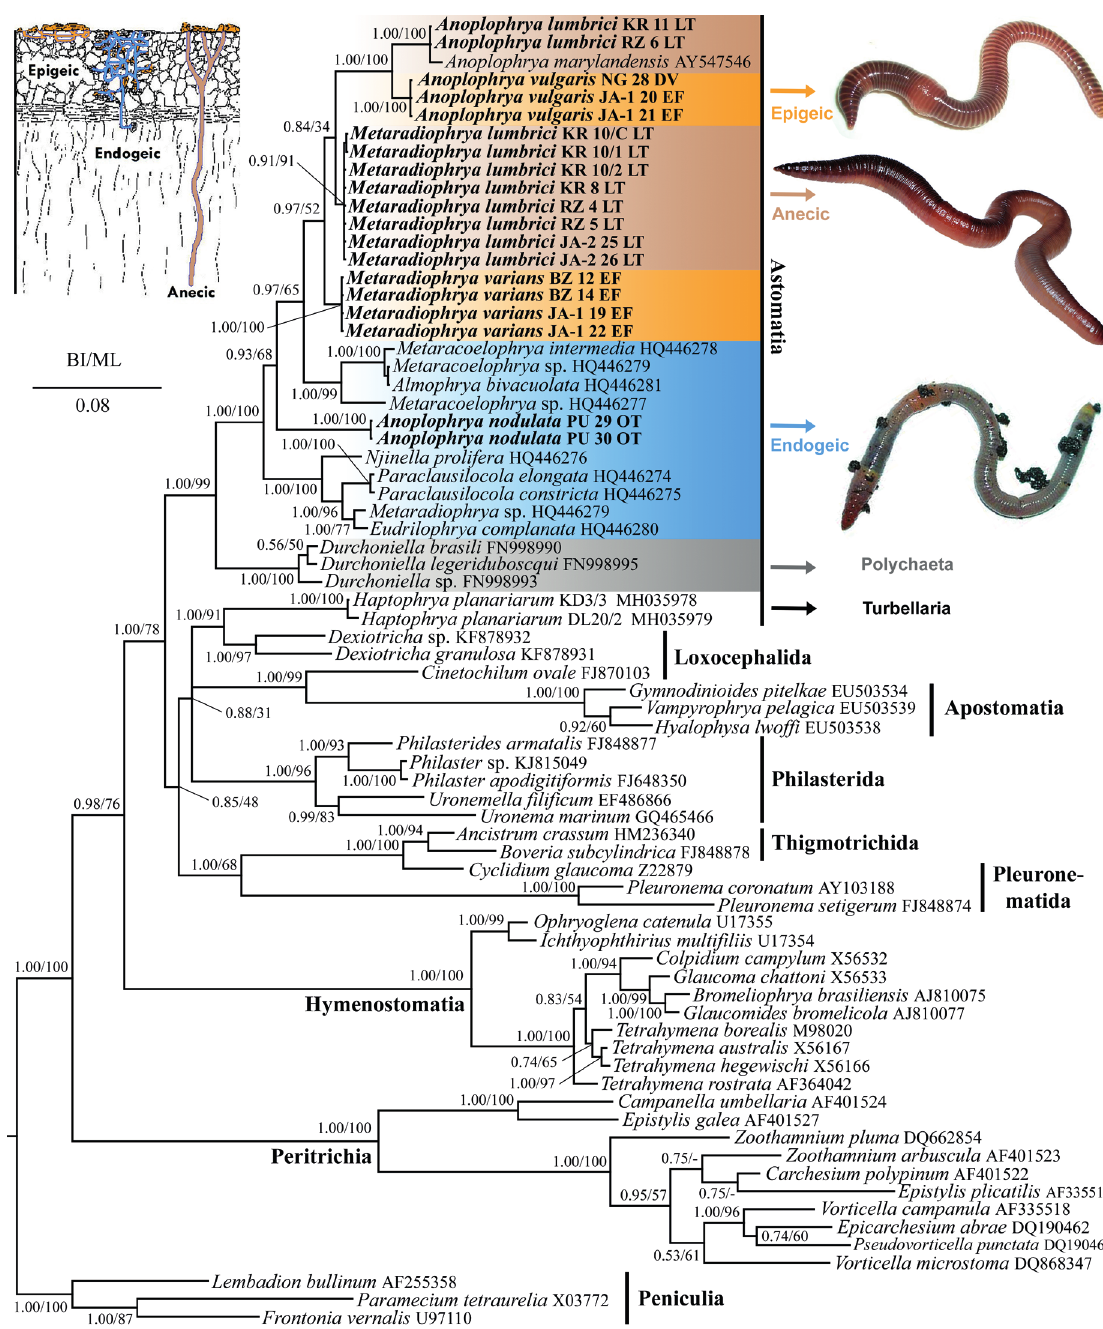
Fig. 14. Small subunit rRNA gene phylogenetic tree showing systematic positions of astome ciliates isolated from lumbricid earthworms. Posterior probabilities for Bayesian Inference (BI) and bootstrap values for Maximum Likelihood (ML) were mapped onto the 50%-majority rule Bayesian consensus tree. Dashes indicate ML bootstrap values below 50%. The phylogenetic tree suggests that the evolution of endosymbiotic astome ciliates has proceeded through a specialization to various ecological and systematic groups of their host organisms. Sequences in bold face were obtained during this study. For specimen codes and further details, see Table 4. The scale bar denotes eight substitutions per one hundred nucleotide